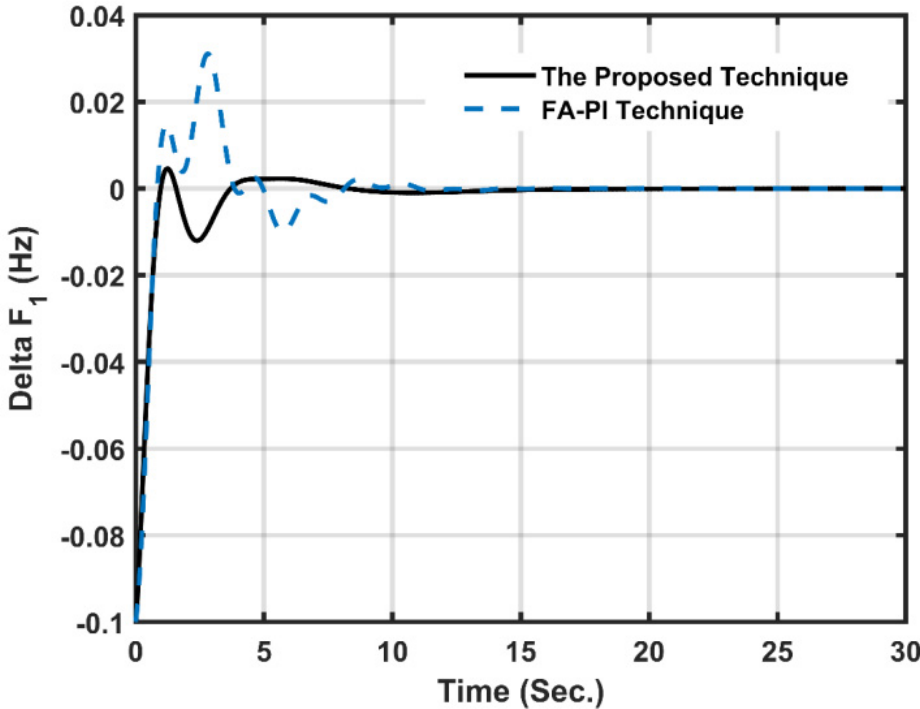
Figure 14. Frequency deviation in area 1 under disturbance in thermal demand.